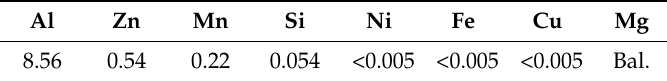
Table 1. Chemical composition of AZ91D (in